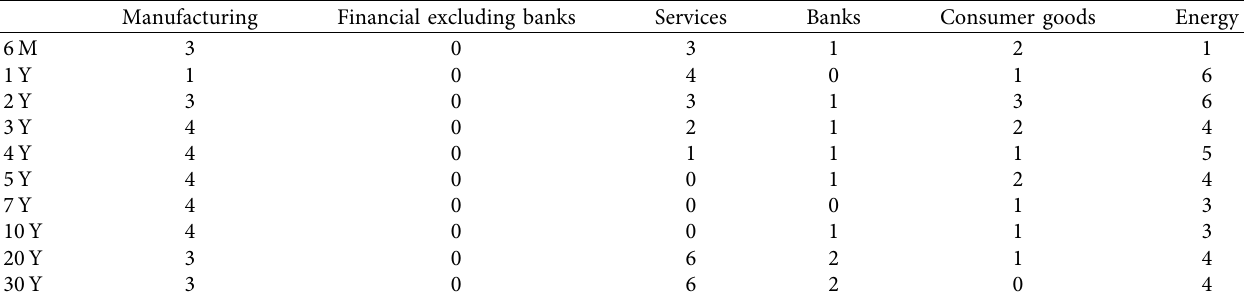
Table 5: Wald coefficient test summary, the number of times when the null hypothesis was not rejected for CDS spreads in different years, 2010–2019.